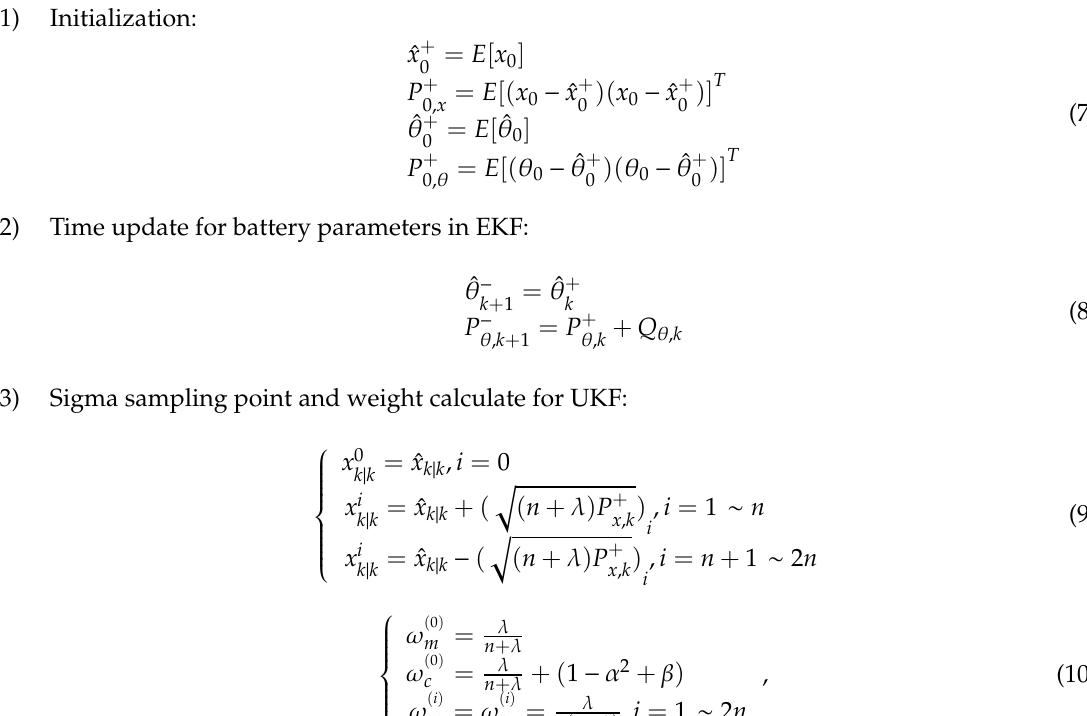
Table 1. Battery parameters.